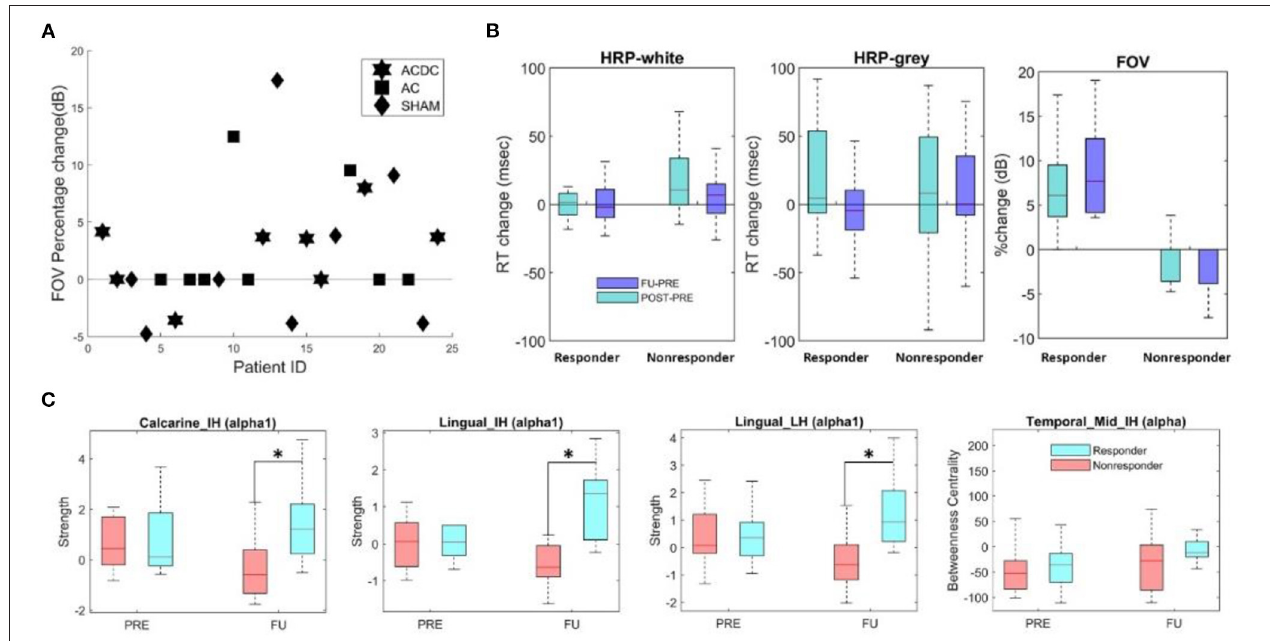
FIGURE 4 | (A) Percentage change of FOV per group for responders with values above zero ( n = 10) and non-responders ( n = 14). (B) Boxplot of absolute median change (HRP) and percentage of FOV (unit: dB) in responder and non-responders. Both groups had comparable reaction times (RT), but (per definition) the percentage change of FOV was significantly higher ( z = 4.17, p < 0.001). (C) The local node strength in the low alpha band was significantly enhanced in responders in calcarine and lingual areas of both hemispheres (* p < 0.05). The FU centrality of Temporal_Mid_IH was higher than the PRE ( p >